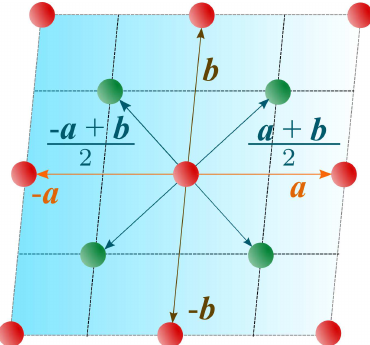
Figure 1. Schematic presentation of the pentacene lattice. A pair of exchange integrals corresponds to each set of the lattice vectors { a , − a } , { b , − b } , and { a + b